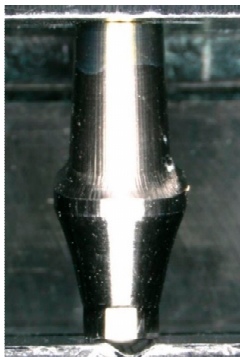
Figure 1. Titanium prototype abutment (Esthetic Abutment NobelReplace regular platform (RP) 3 mm).